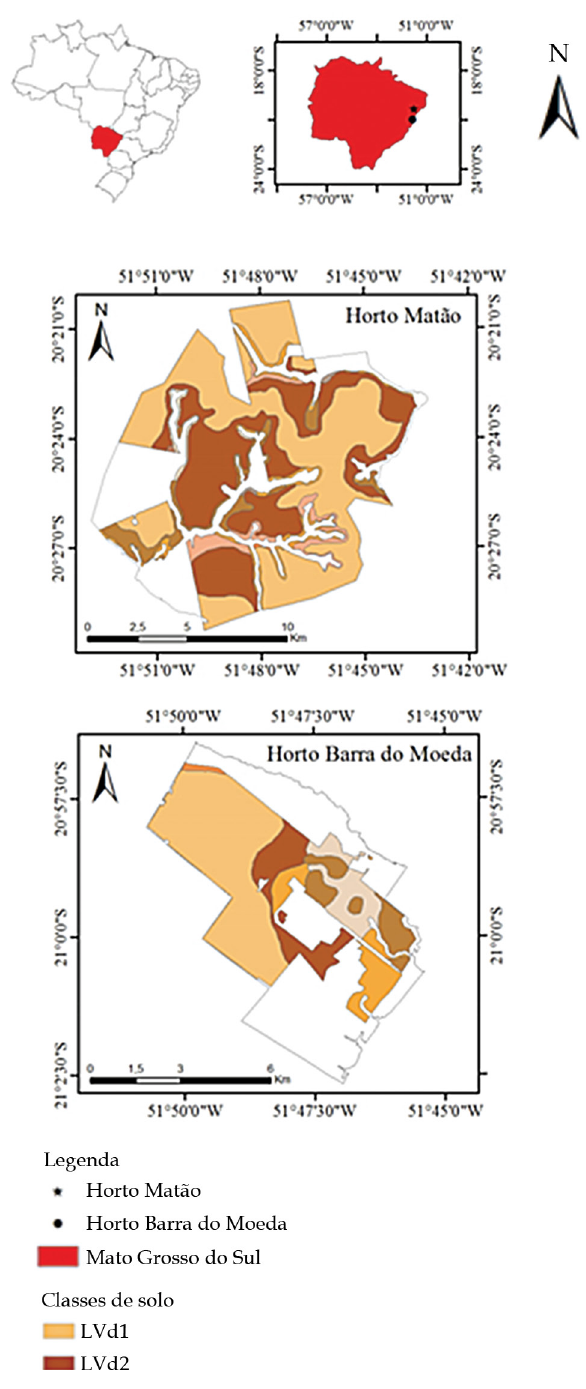
Figura 1. Sub-bacias estudadas e abrangência do Latossolo Vermelho distrófico típico, textura média-alta, fase floresta (LVd1) e Latossolo Vermelho distrófico típico, textura média-baixa, fase cerrado